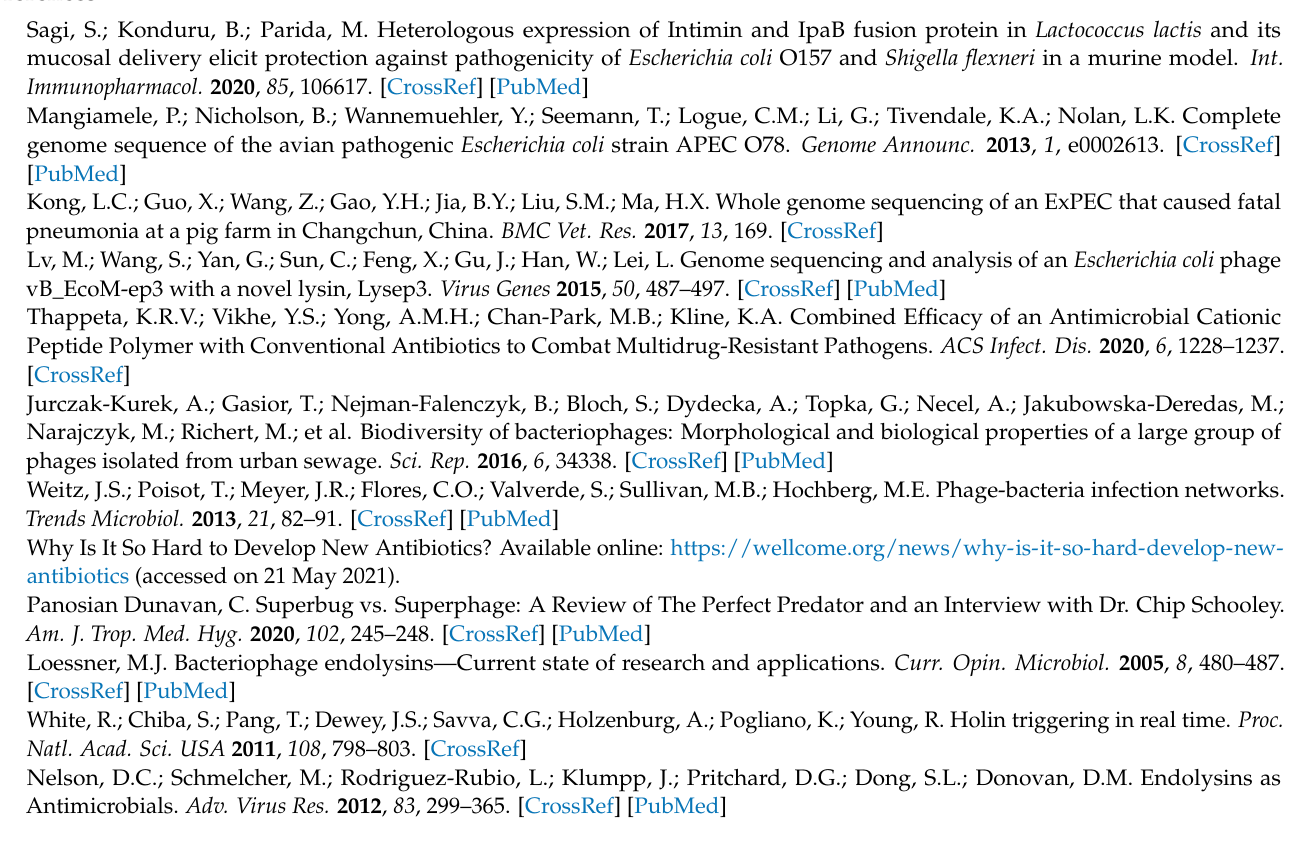
mutants. Table S3: The predicted prophages of Chitinimonas arctica R3-44 T . Figure S1: The induced prophage morphology of Chitinimonas arctica R3-44 T under TEM. Figure S2: Phage morphology under TEM. Figure S3: PCR detection of the major capsid gene in Chitinimonas arctica R3-44 T . Figure S4: The influence of reaction temperature on endolysin